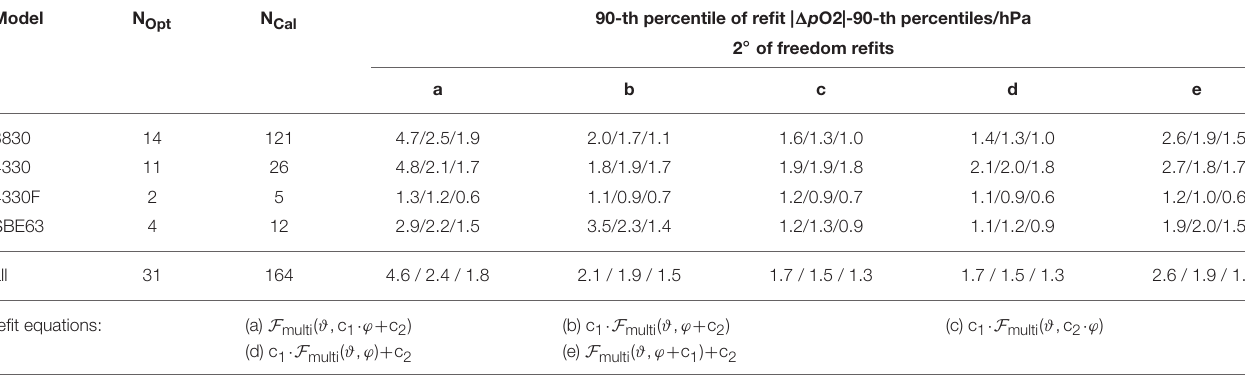
TABLE 2 | Accuracy of multi-point F multi O 2 - ϑ -response adjustments to individual multi-point optode calibrations using refit approaches with two degrees of freedom (a–e).